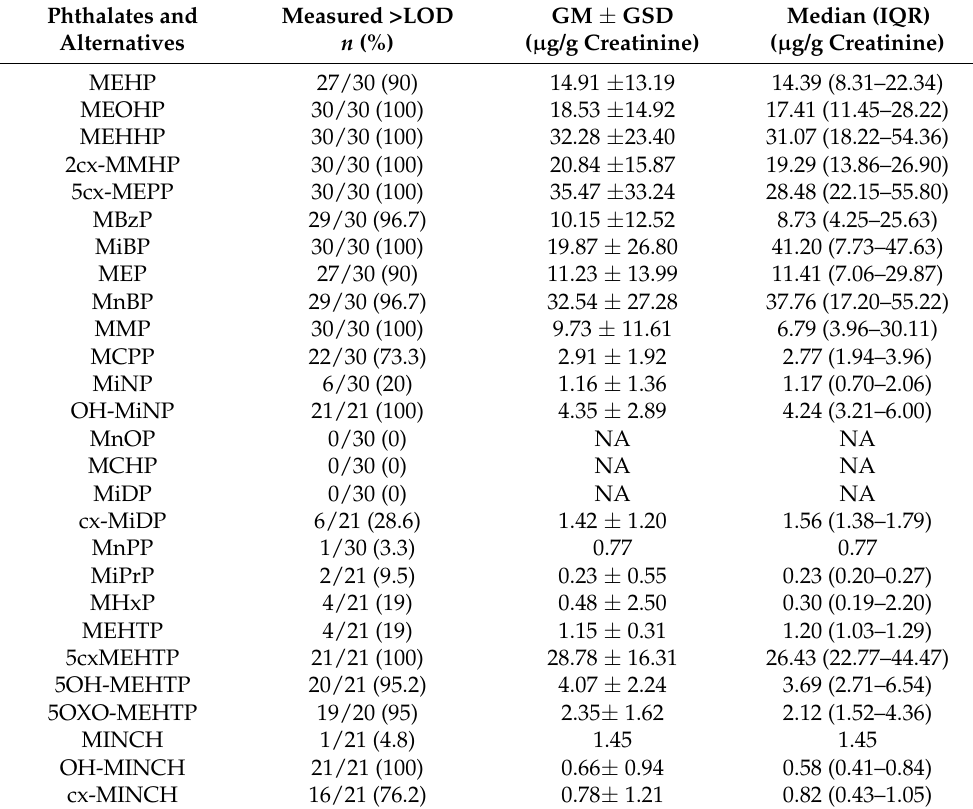
Table 2. Urinary concentrations of phthalate and alternative plasticizer